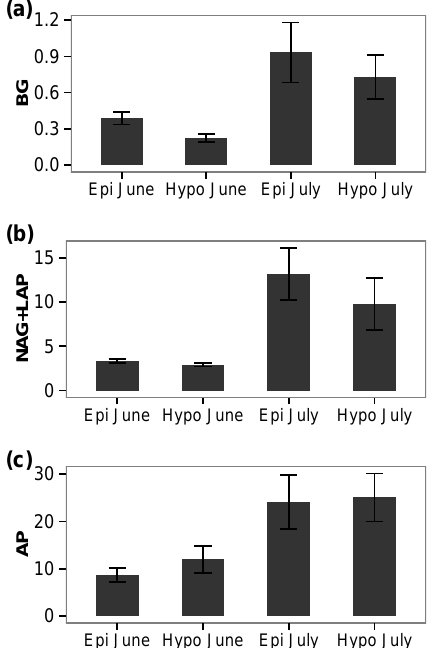
Figure 3. Absolute enzyme activities for (a) β -1,4-glucosidase (BG), (b) β -1,4-N-acetylglucosaminidase and leucine aminopepti- dase (NAG + LAP), and (c) alkaline phosphatase (AP) across epil- imnia and hypolimnia of study lakes, from June to July. Error bars are standard deviation. Units of activity are µmolmL − 1 h − 1 .